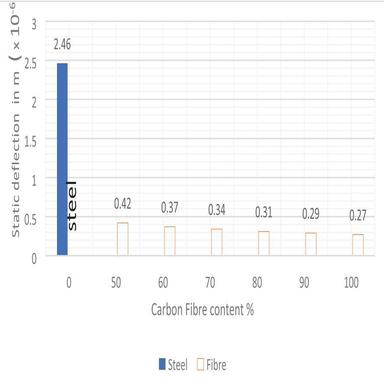
Static deflection of steel and composite drive shaft.